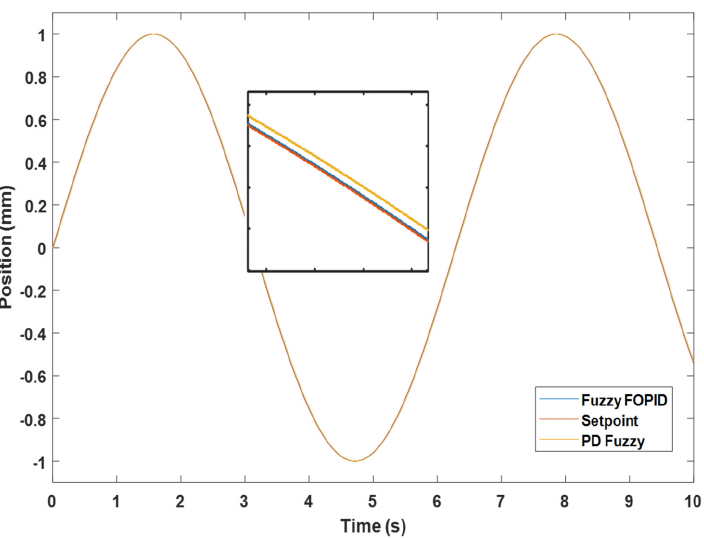
Figure 18. Fuzzy FOPID and fuzzy PID experimental performances. Figure 19 illustrates the performance of the fuzzy FOPID controller when testing the obtained position by the stroke with sinewave input. This demonstrates that the fuzzy FOPID controller successfully minimizes the overshoot in the system’s response.